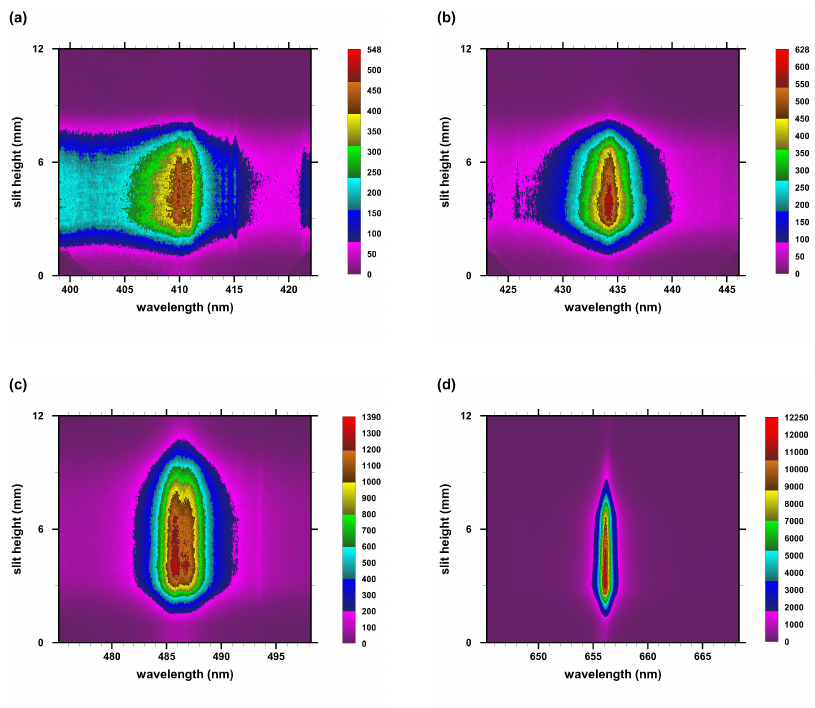
Figure 3. Recorded Balmer-series hydrogen lines at 2.25- µ s time delay, 0.025- µ s gate. ( a ) H δ , ( b ) H γ , ( c ) H β , and ( d ) H α .